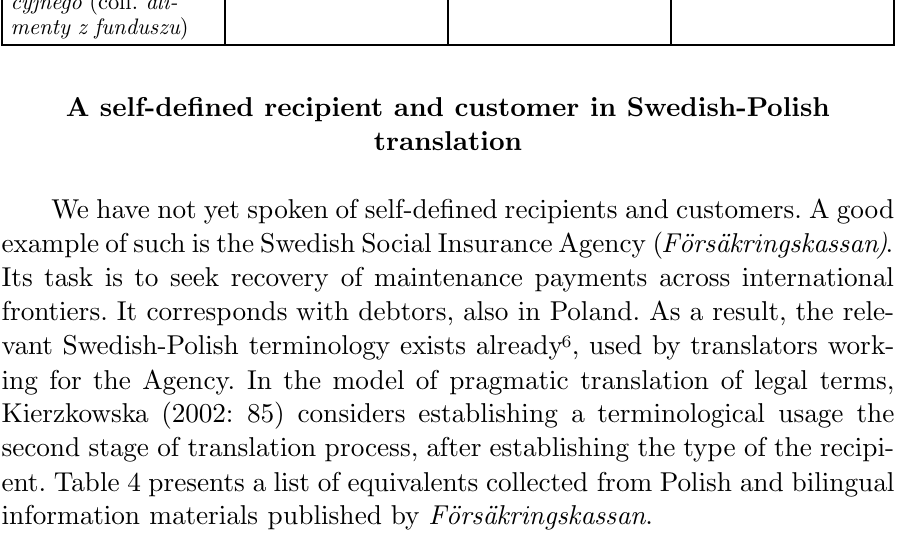
Established Polish equivalents (L2) for the Swedish terms (L1) underh˚allsbidrag and underh˚allsst¨od in the translations